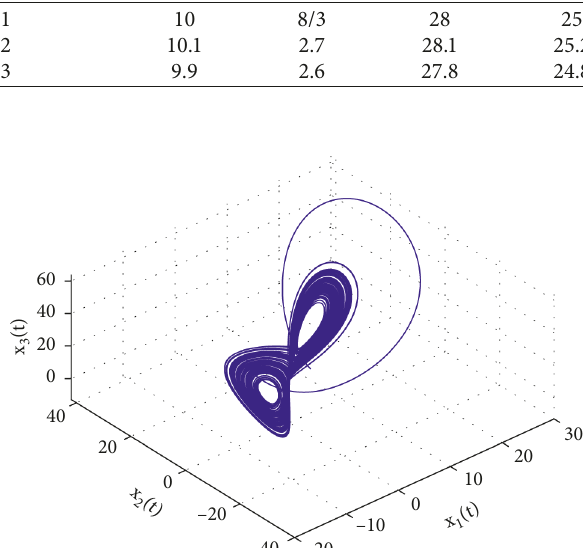
Figure 1: Behavior of (77) with x ( 0 ) � [ 12 , 15 , − 13 ] T for mode 1.